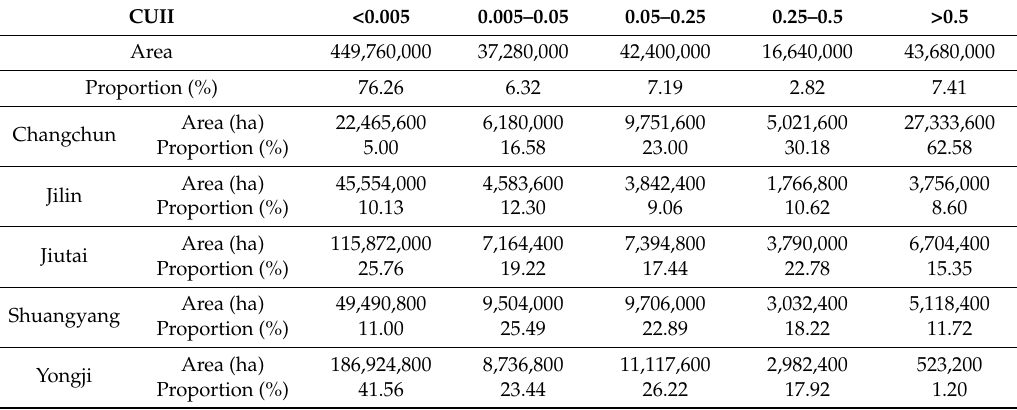
Figure 4. Distribution of urban land ( a ) and common urbanization intensity index (CUII) ( b ) in the CJEZ in 2000 and 2015. Table 6. Average CUII in different regions.